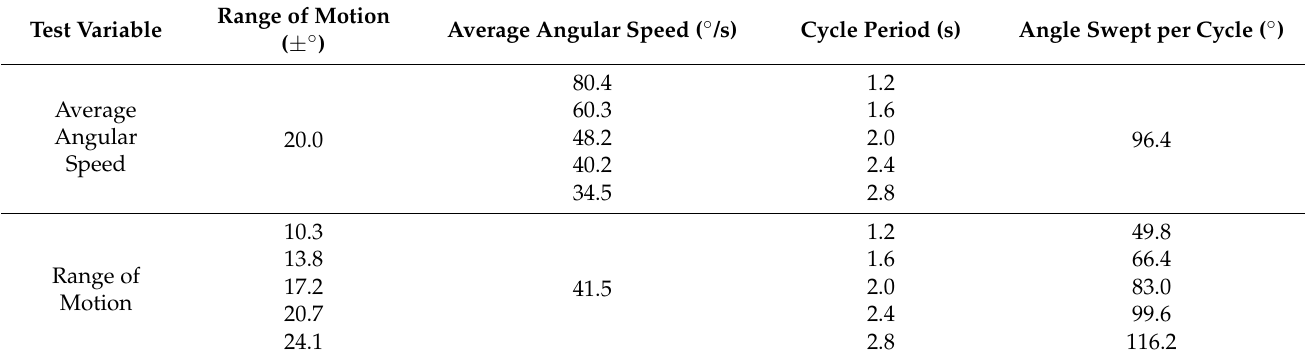
Table 2. Robot Arm Test